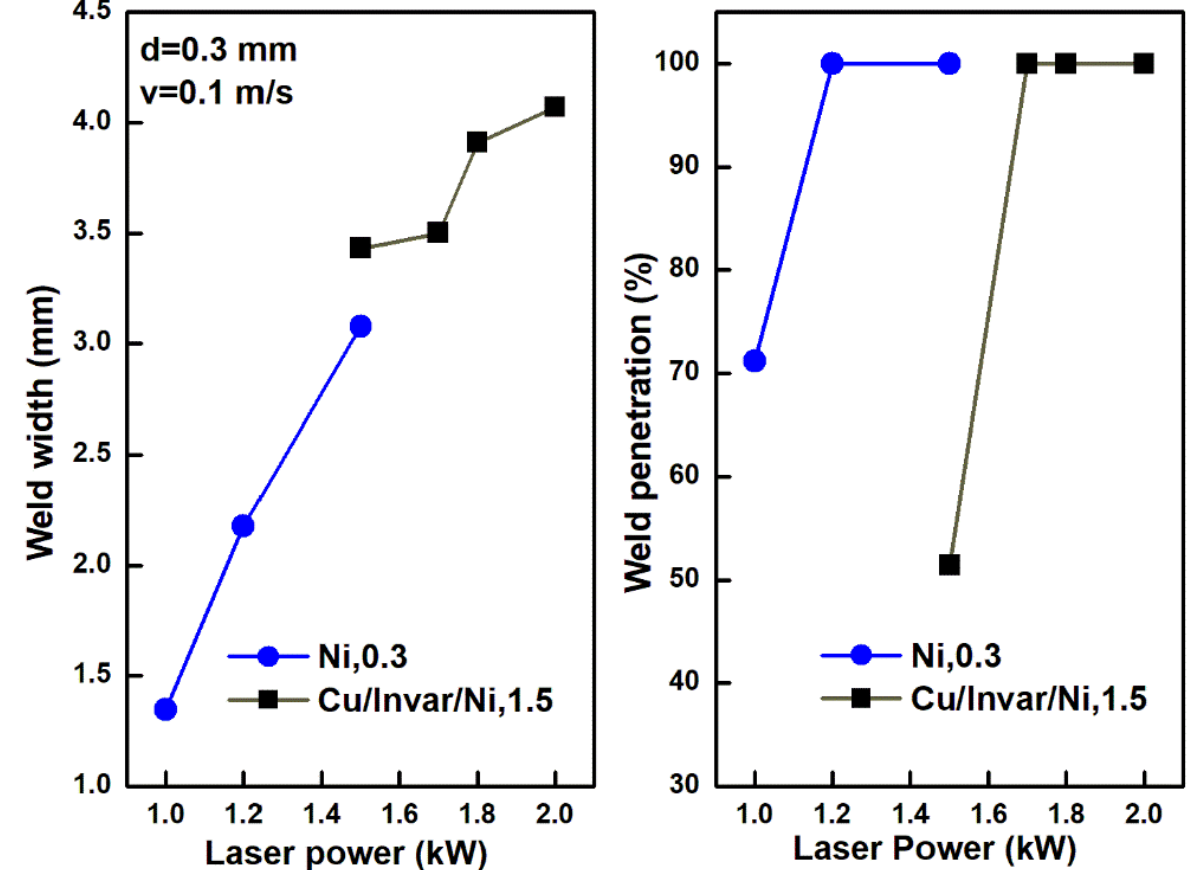
Figure 7. Effect of laser power on the weld formation and weld penetration. When using 0.1/2/0.1 mm thick Cu/Invar/Ni as brazing filler metal with a laser power